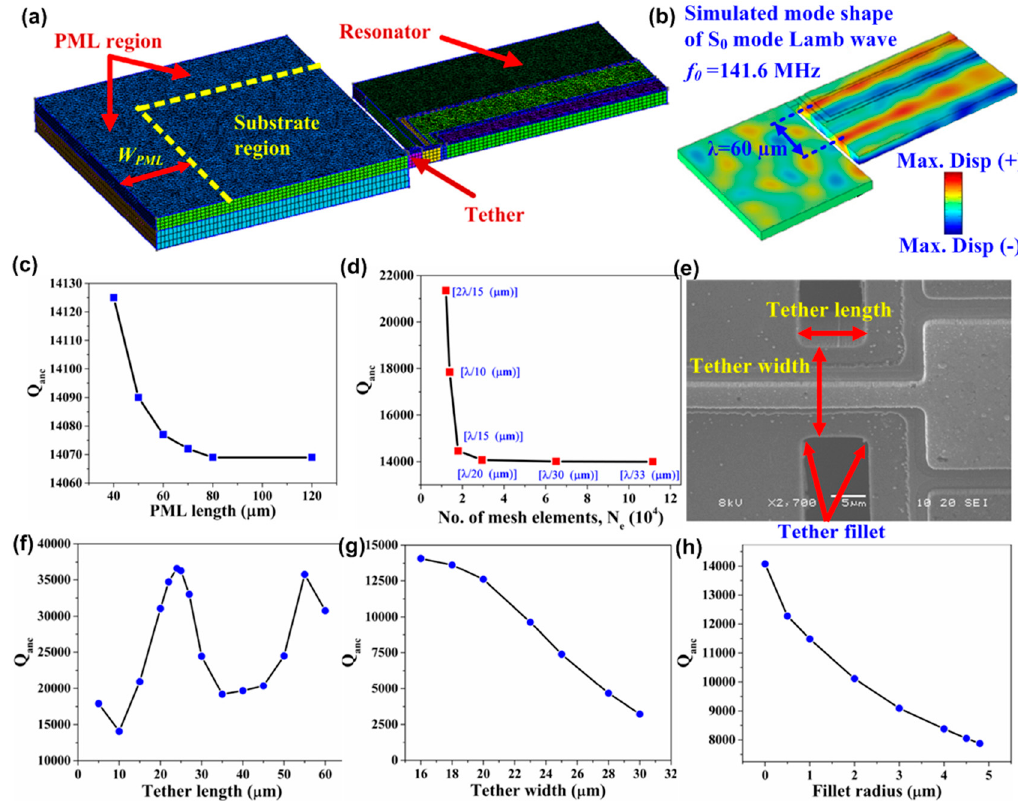
Figure 3. Evaluation of anchor loss in a AlN-on-Si resonator using numerical analysis: ( a ) implementation of PML in a 3D model; ( b ) simulated vibration mode shape of S 0 Lamb wave at 141.6 MHz; ( c , d ) computed Q anchor in relation to PML length and number of mesh elements; ( e ) scanning electron micrograph (SEM) for the tether part of the fabricated resonator; ( f – h ) computed Q anchor with respect to tether length, tether width and fillet radius. This figure is reproduced from [50] (© 2019 IOP Publishing).